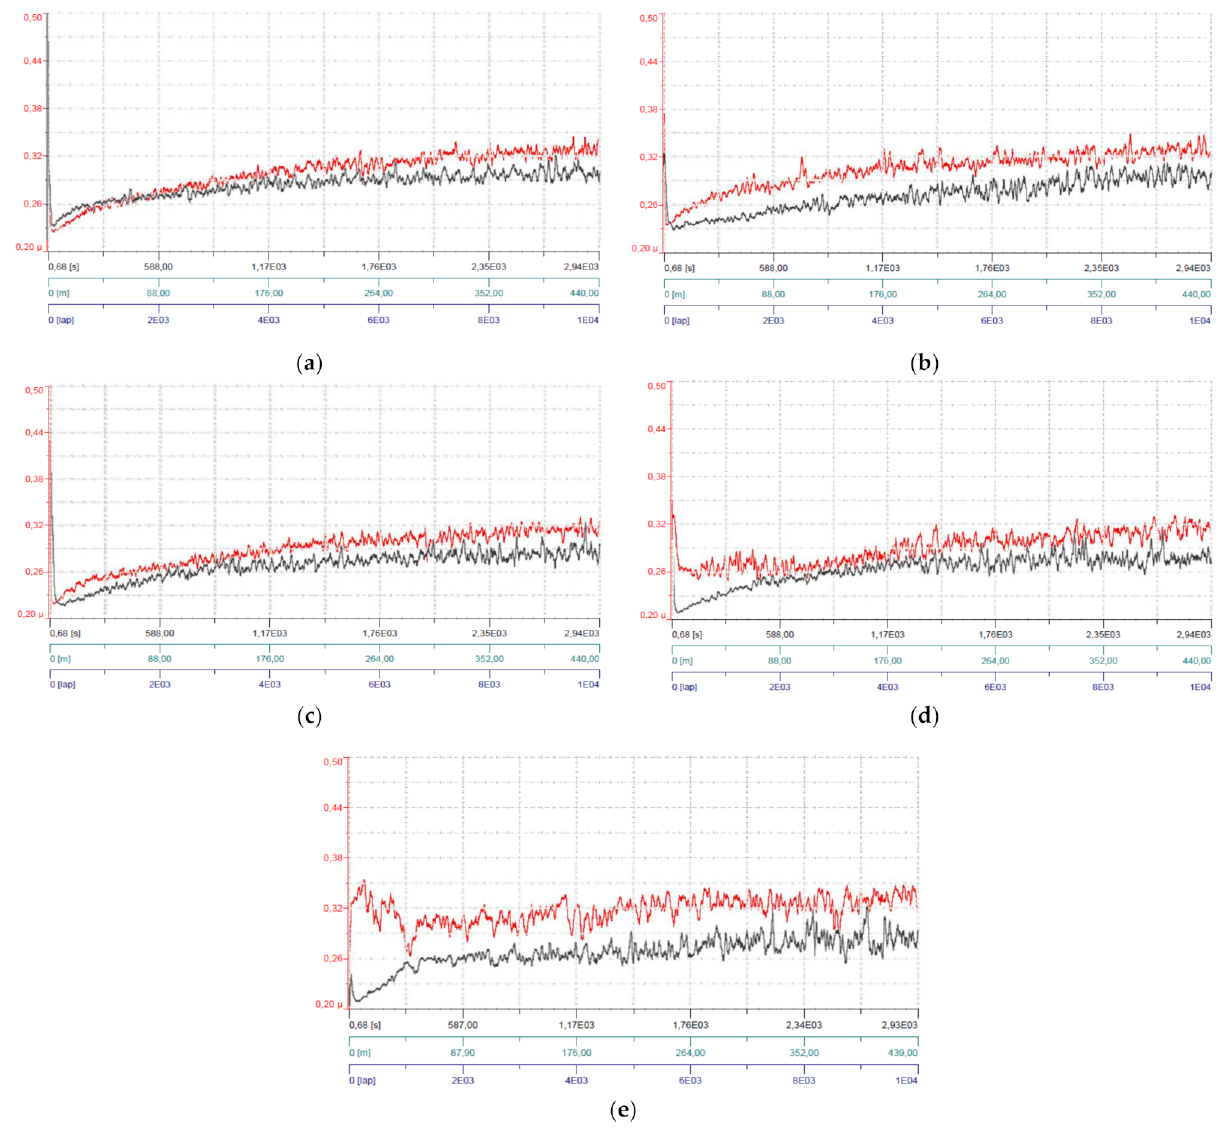
Figure 5. Evolution of the friction coefficient for natural (red curves) and black (black curves) PLA during tribological testing: ( a ) 200 ◦ C ( b ) 210 ◦ C ( c ) 220 ◦ C ( d ) 230 ◦ C, ( e ) 240 ◦ C. Axis explanations: Vertical axis: µ (friction coefficient); Horizontal axis: [s] (test duration, up to 2930 s), [m] (sliding distance, up to 439 m) and [lap] (number of laps, up to 10,000